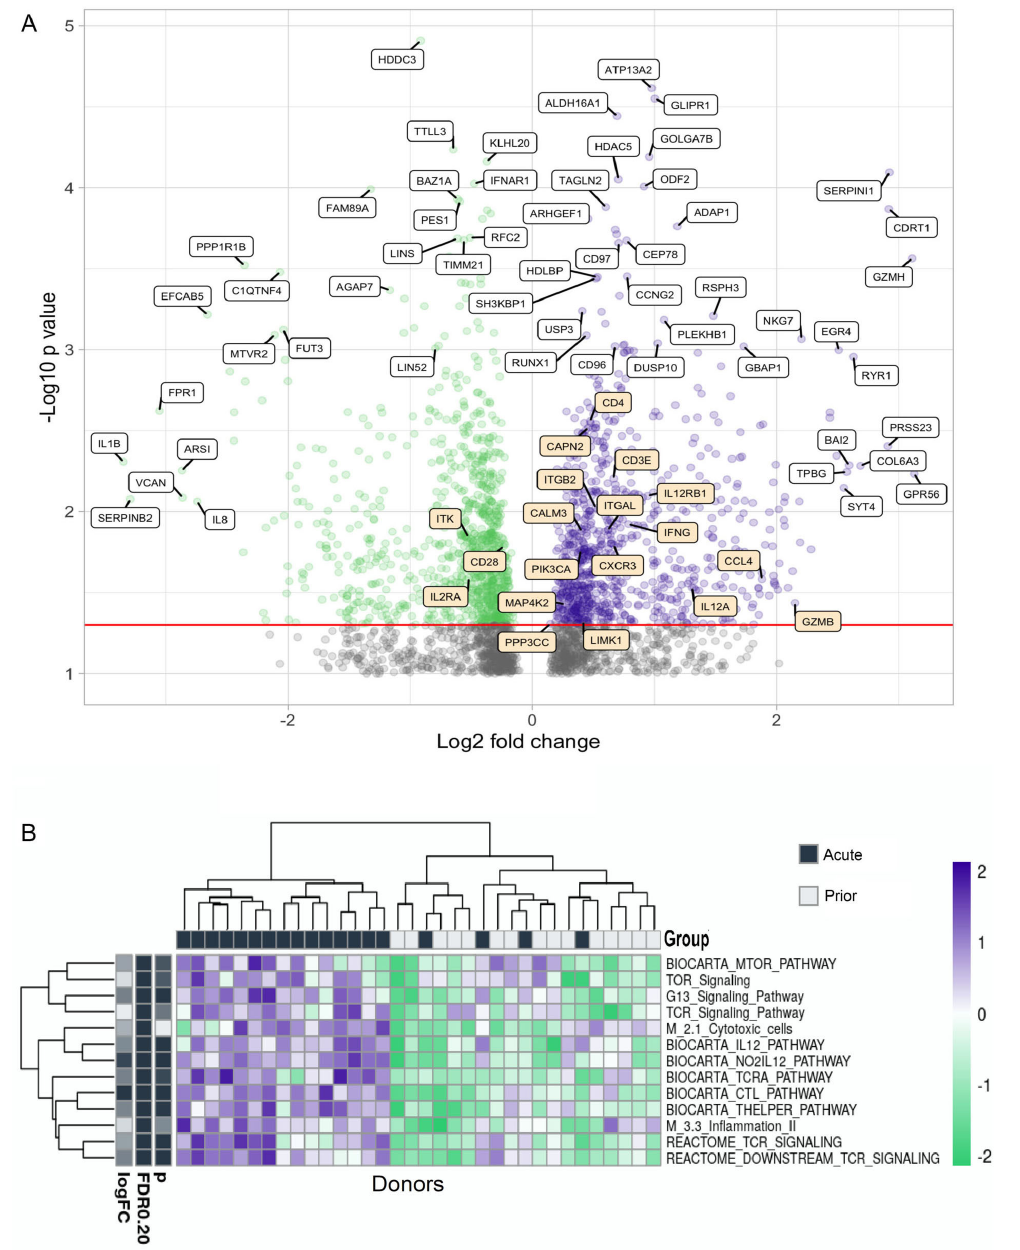
Figure 6. Gene expression and pathway analysis of CD4+ memory T cells sorted from PBMCs from acute and prior individuals. (A) Volcano plot showing the differences in gene expression in memory CD4+ T cells in acute group donors vs prior group donors. Most significantly upregulated genes by P value and by log2-fold change are indicated with white labels, while genes from the BIOCARTA T-cell pathway are indicated in orange. This pathway includes the following: ‘BIOCARTA_CTL_PATHWAY’, ‘BIOCARTA_CTLA4_PATHWAY’, ‘BIOCARTA_MAL_PATHWAY’, ‘BIOCARTA_MEF2D_PATHWAY’, ‘BIOCARTA_NKT_PATHWAY’, and ‘BIOCARTA_TOB1_PATHWAY’. (B) Heatmap of different pathway activation patterns of CD4+ T cells from donors in acute group and prior group. Donors are clustered by pathway patterns. (*: P